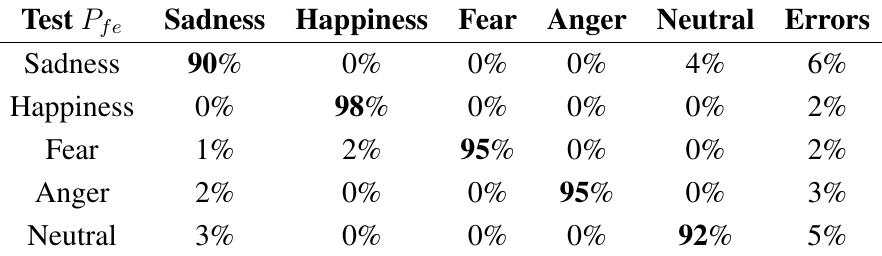
Table 7. Robustness of the system of recognition and imitation of facial expressions.